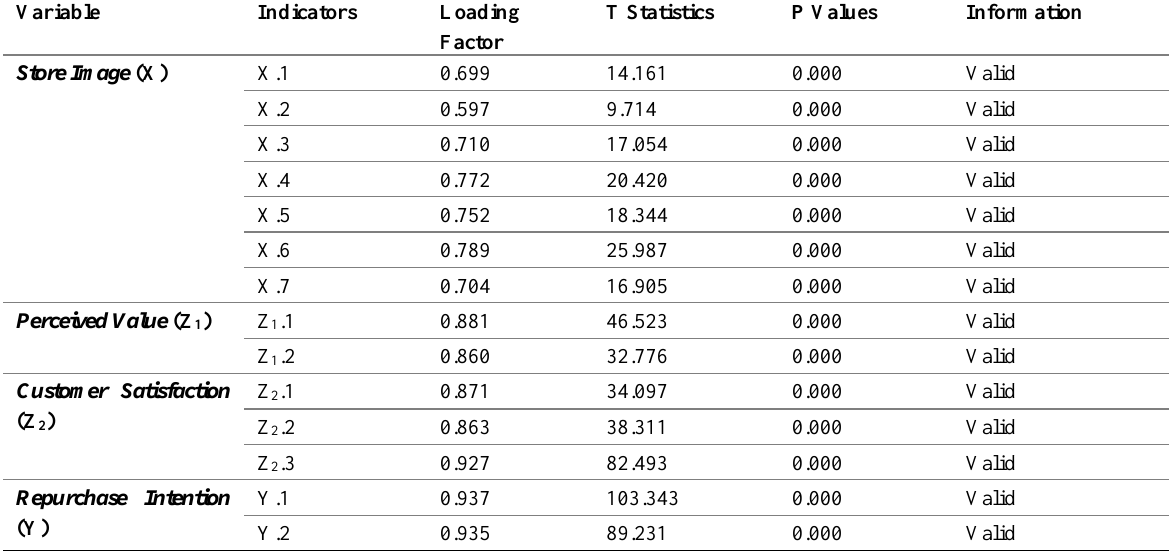
Table 1: Convergent Validity Test